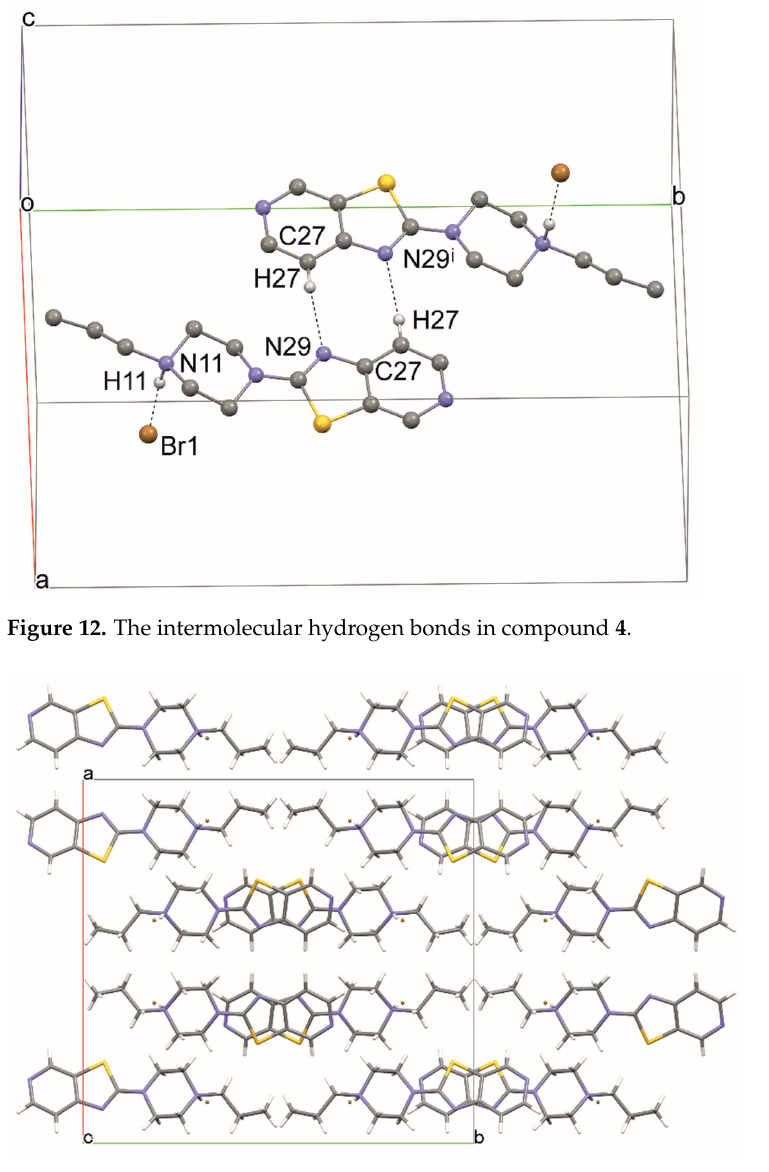
Figure 13. The crystal packing of 4 .